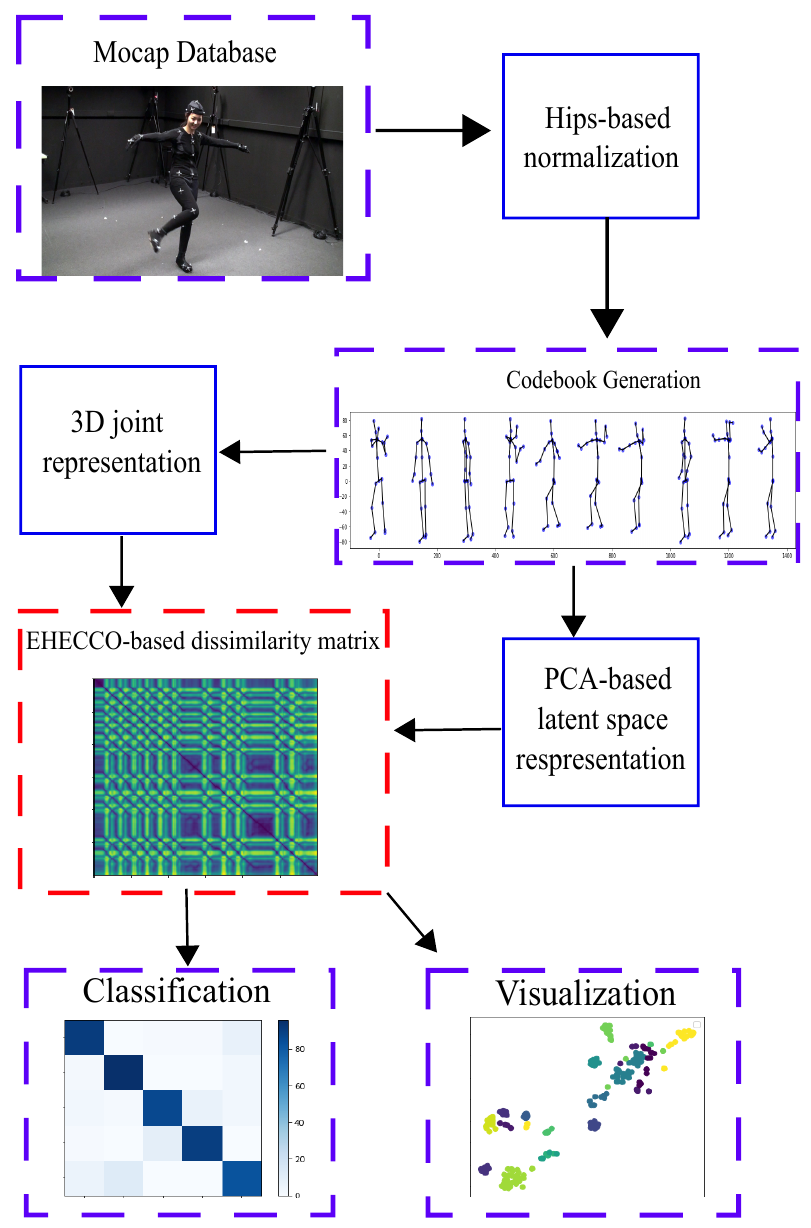
Figure 2. EHECCO-based Mocap data classification framework. Hip joint normalization and spectral clustering-based codebook generation are carried out to extract relevant skeletal poses. Then, 3D joint representation ( X ) and PCA-based latent projection ( Y ) are used to support the EHECCO metric from joint probability. Lastly, an SVM classifier is trained from the EHECCO distance that also supports 2D data